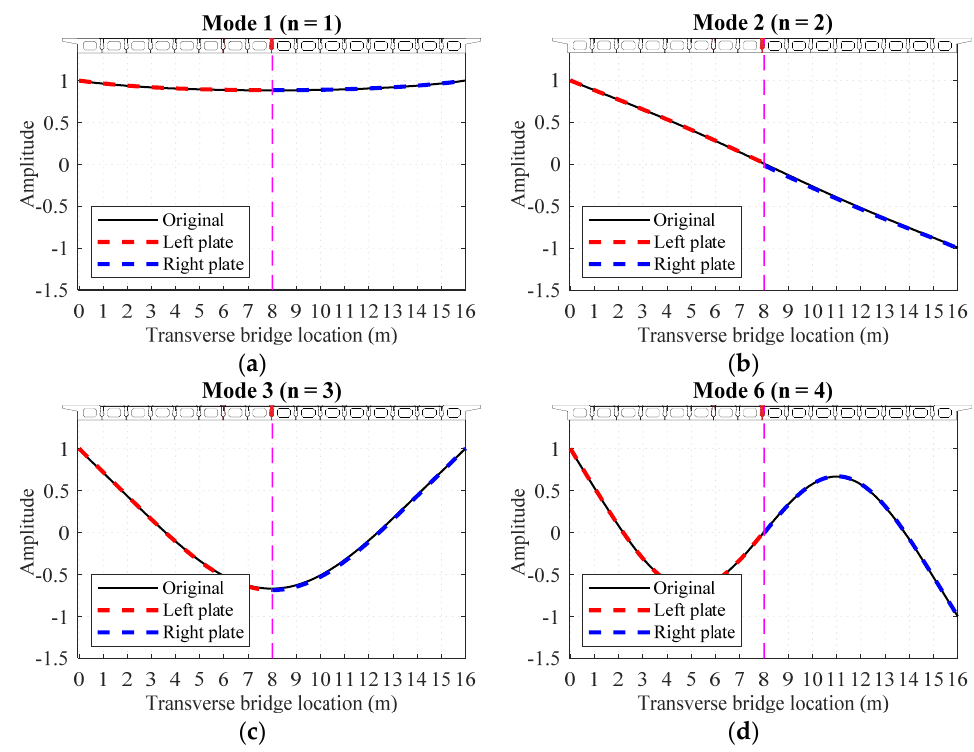
Figure 8. Comparison of the first four transverse modal shapes: hinge position η = 8 m: ( a ) Mode 1, n = 1; ( b ) Mode 2, n = 2; ( c ) Mode 3, n = 3; ( d ) Mode 6, n = 4.